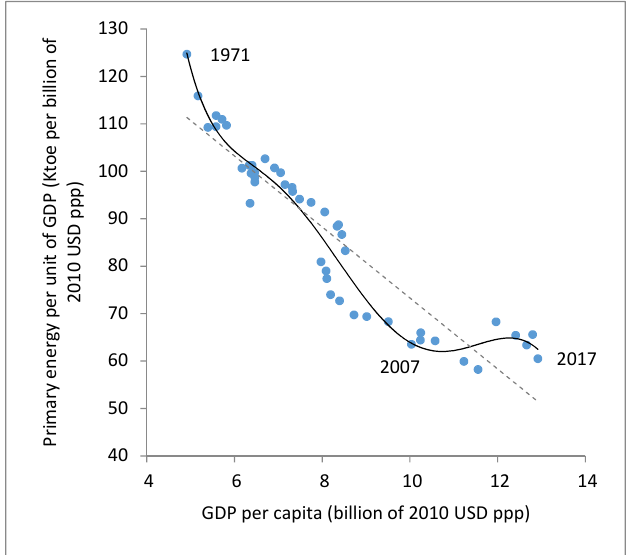
Figure 1. Relative delinking of energy. (Source: Produced by the authors with IEA data [3]).